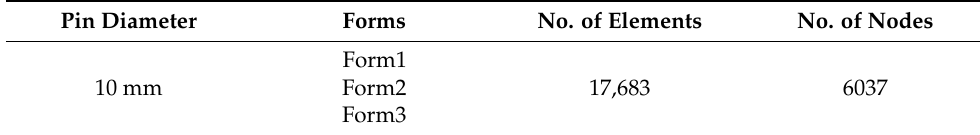
Table 2. Element and Node